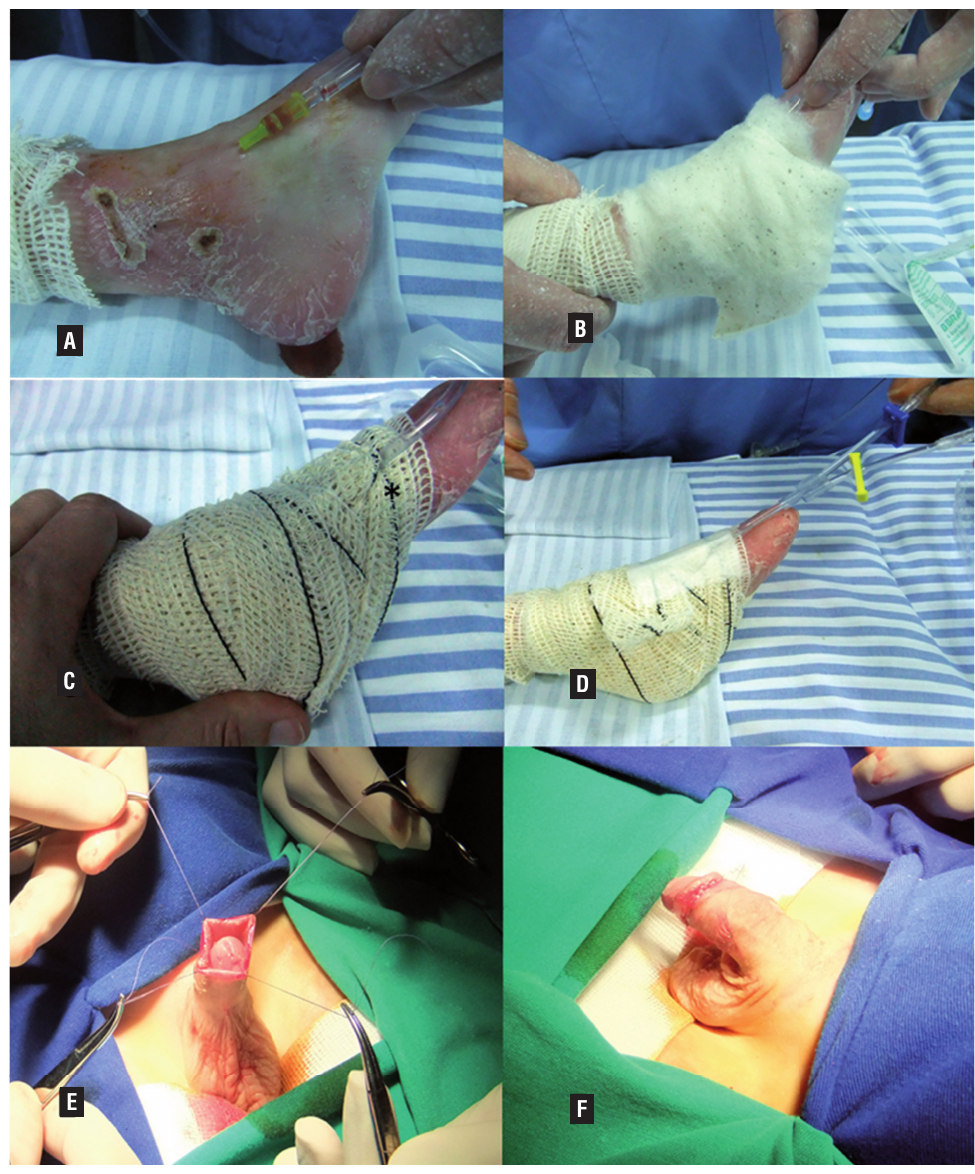
figure 2 - Vein catheter fi xation: A peripheral vein was punctured in the right foot (A). The skin was protected by a cotton bandage (B). The cotton bandage was covered by an elastic bandage and the venous catheter was fi xed to the bandage by a knot (*) (C). The catheter was fi xed again to the bandage by an adhesive (no adhesive tapes were fi xed to the skin) (D). An effort was done not to touch the penile skin to insert the stitches between the stay sutures (non-touch technique) (E). final result